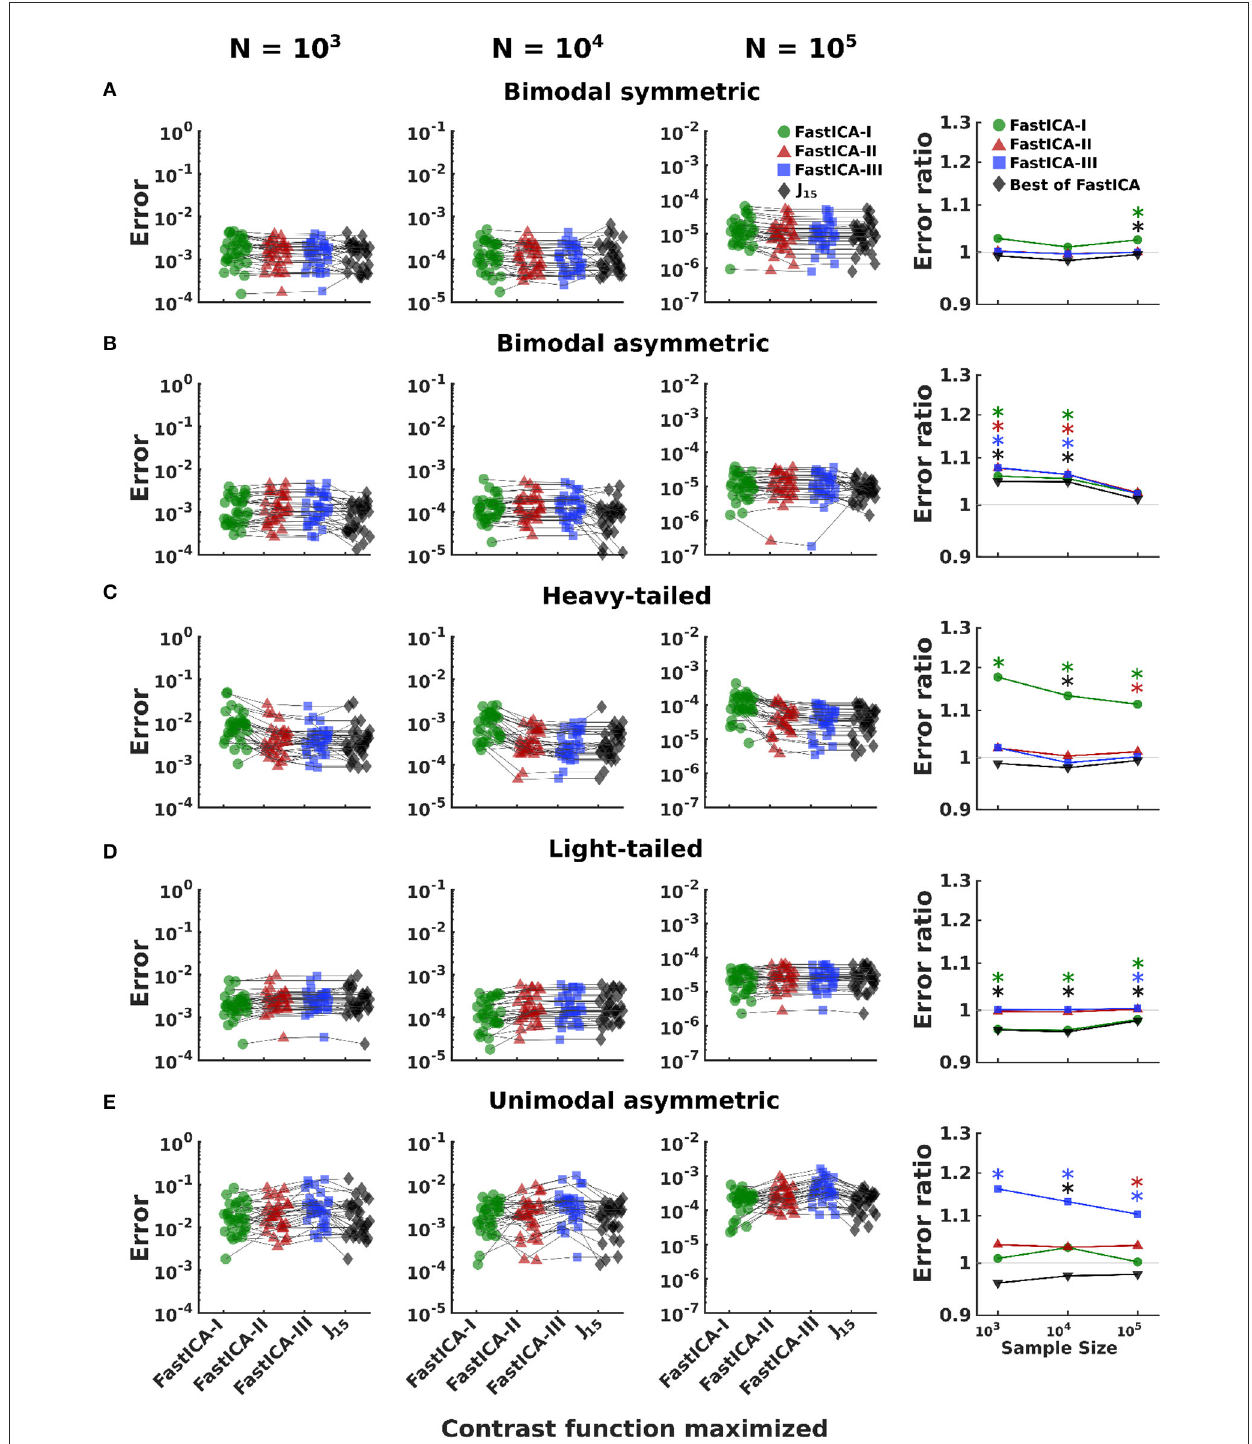
FIGURE5 Comparison of performance of J 15 to that of contrast functions of FastICA for 5D distributions. Rows (A–E) show results for datasets consisting of one non-Gaussian signal (the signals of Figure 3) mixed with four Gaussian signals. The first three columns show results for a range of sample sizes. For all 30 simulations of a distribution and sample size, we report the error in estimation of the direction of unmixing identified by optimizing each contrast function (see Section 2.4.1). Results for a single dataset are connected by thin black lines. The last column compares the error achieved by J 15 to the three FastICA methods. Colored symbols compare J 15 to each FastICA method individually. Gray symbols J 15 to the best performing FastICA method for each dataset. Error ratios greater than 1 indicate that J 15 has the smaller error. *Indicates significant ( p < 0.05) differences, via a two-tailed paired t -test, with p -values computed separately for each